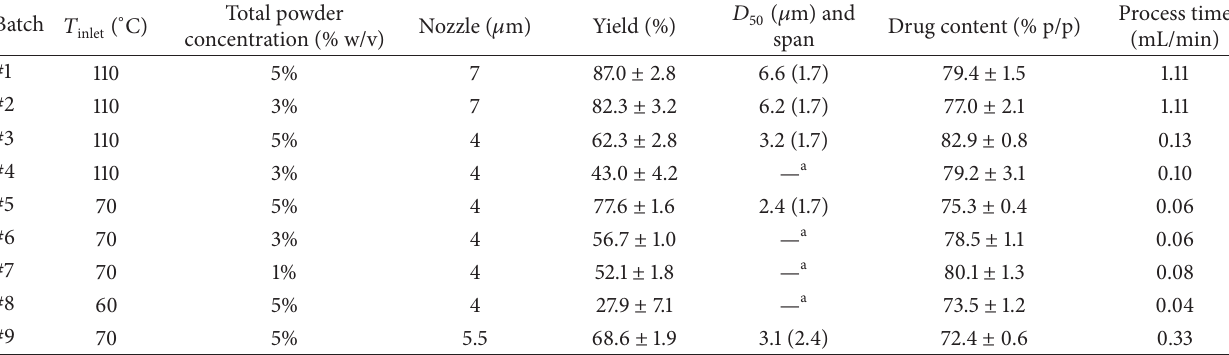
Table 1: Klys/leu powders produced by nanospray drier: process parameters, yield, drug content, and particle size distribution (15% leu and 30%